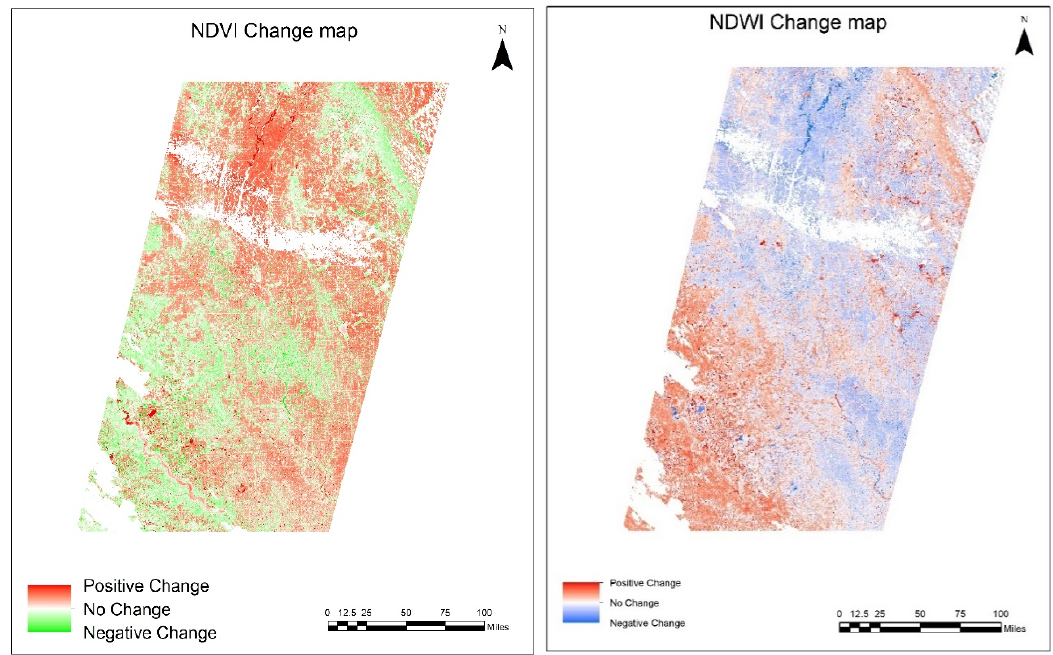
Figure 6. NDVI change detection map ( left ) and NDWI change detection map ( right ). We used Otsu thresholding to separate flooded and non-flooded pixels in the NDVI difference map. We used NDVI instead of NDWI or both indices because of the substantial overlap between the two difference images. The histogram of NDVI values shows a bi- modal distribution (Figure 7) which we interpret as the boundary between two different groups of pixels (flooded and not flooded, which we interpret as candidates for unplanted and planted pixels). The Otsu method provides an automatic, data-driven way of separat- ing the pixels by finding an ideal threshold value, hence limiting the need for subjective thresholding techniques. This method is particularly useful in cases where there are two distinct groups of pixels as in this bimodal distribution. The optimal NDVI change/differ- ence threshold value derived by this technique was − 0.243: we assumed values greater than this threshold to be flooded pixels and values below it to be non-flooded (Figure 8). Figure 7. Bimodal distribution of NDVI change image showing two distinct pixel groups: flooded and non-flooded pixels.